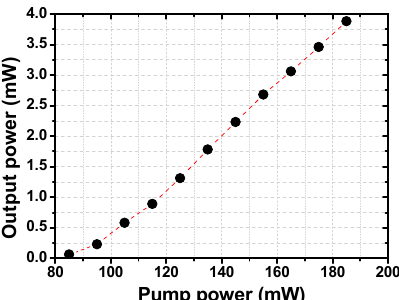
Figure 7. The relationship between the output power and the pump power of the continuous-wave operation.